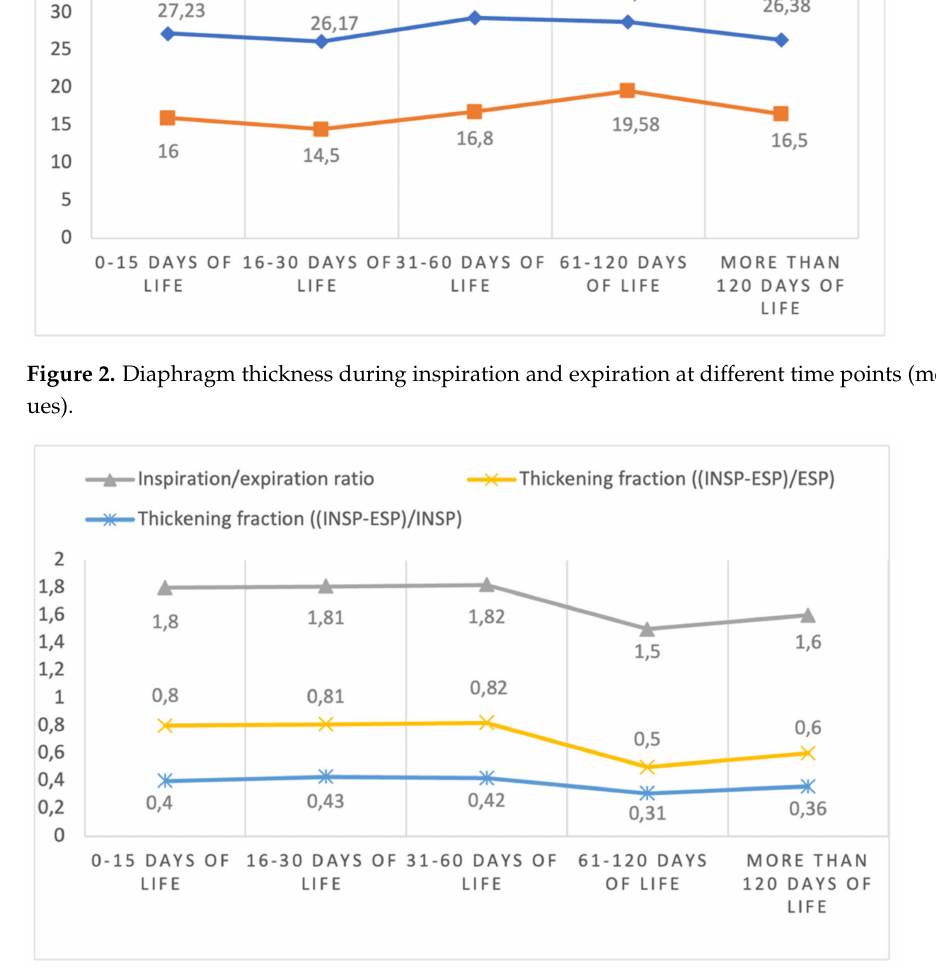
Figure 3. Diaphragm inspiration/expiration ratio and thickening fraction during inspiration and expiration at different time points (mean